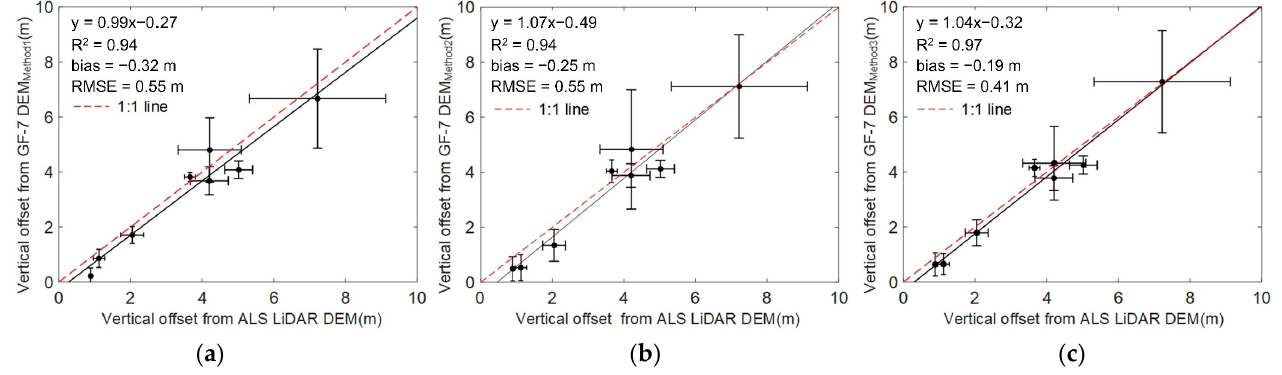
Figure 13. Error scatterplot between the vertical offsets measured by the airborne LiDAR-DEM and ( a ) GF-7 DEM Method1 ; ( b ) GF-7 DEM Method2 ; ( c ) GF-7 DEM Method3 .